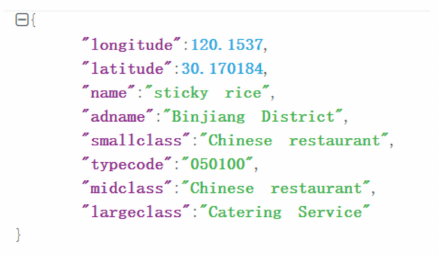
Figure 2. A data sample of Gaode POIs.